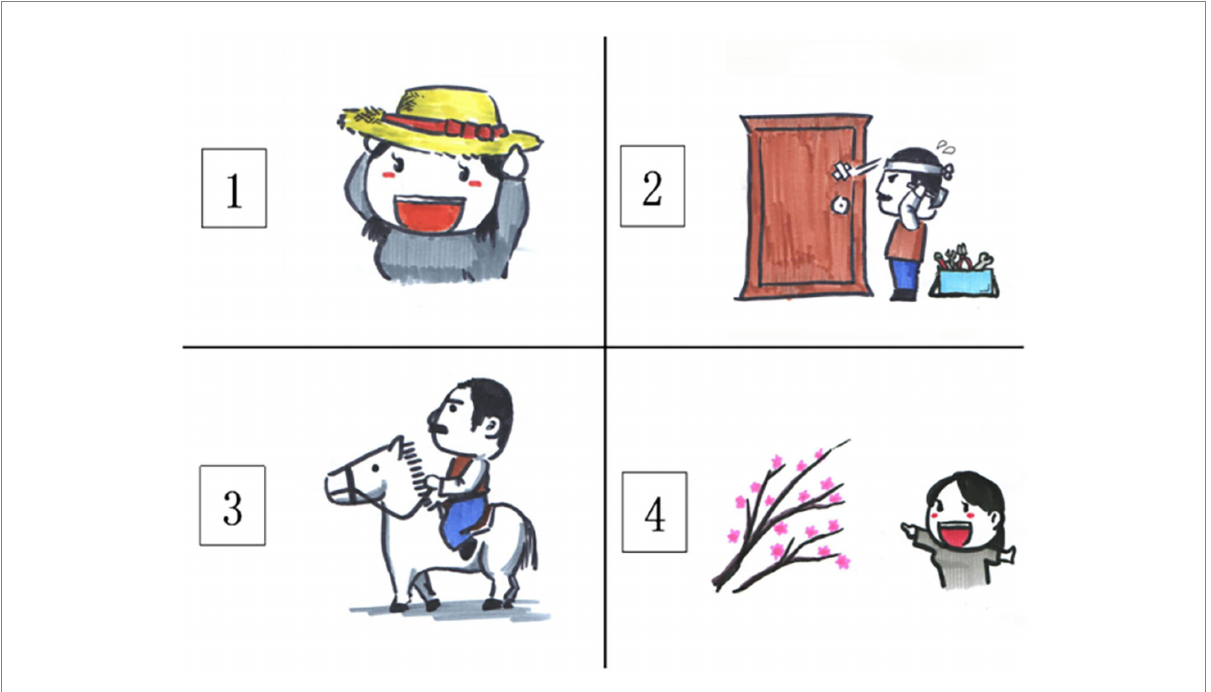
FIGURE 1 Illustration for response screen of the sentence